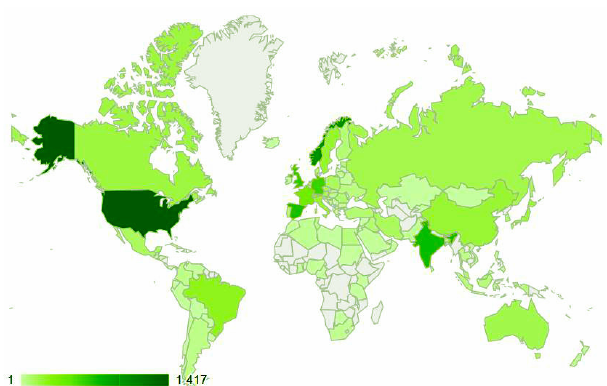
Fig.2: The geographical distribution of our readers. Papers published in JEB have high visibility. All papers published in 201 1 have every month been downloaded more than 100 times